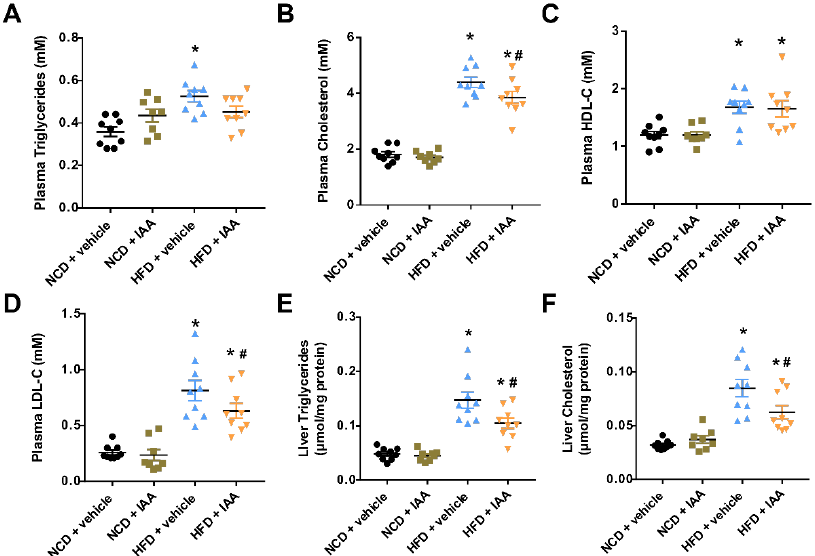
Figure 2. Lipid contents in the plasma and liver of vehicle or indole-3-acetic acid (IAA)-treated mice subjected to normal chow diet (NCD) or high-fat diet (HFD). ( A ), ( B ), ( C ), and ( D ) display plasma total triglycerides, total cholesterol, HDL-C, and LDL-C, respectively. (E) and (F) show the levels of liver triglyceride and cholesterol. Results are described as the mean ± standard error of the mean. n = 8 – 9. * p < 0.05 vs. NCD + vehicle; # p < 0.05 vs. HFD + vehicle.